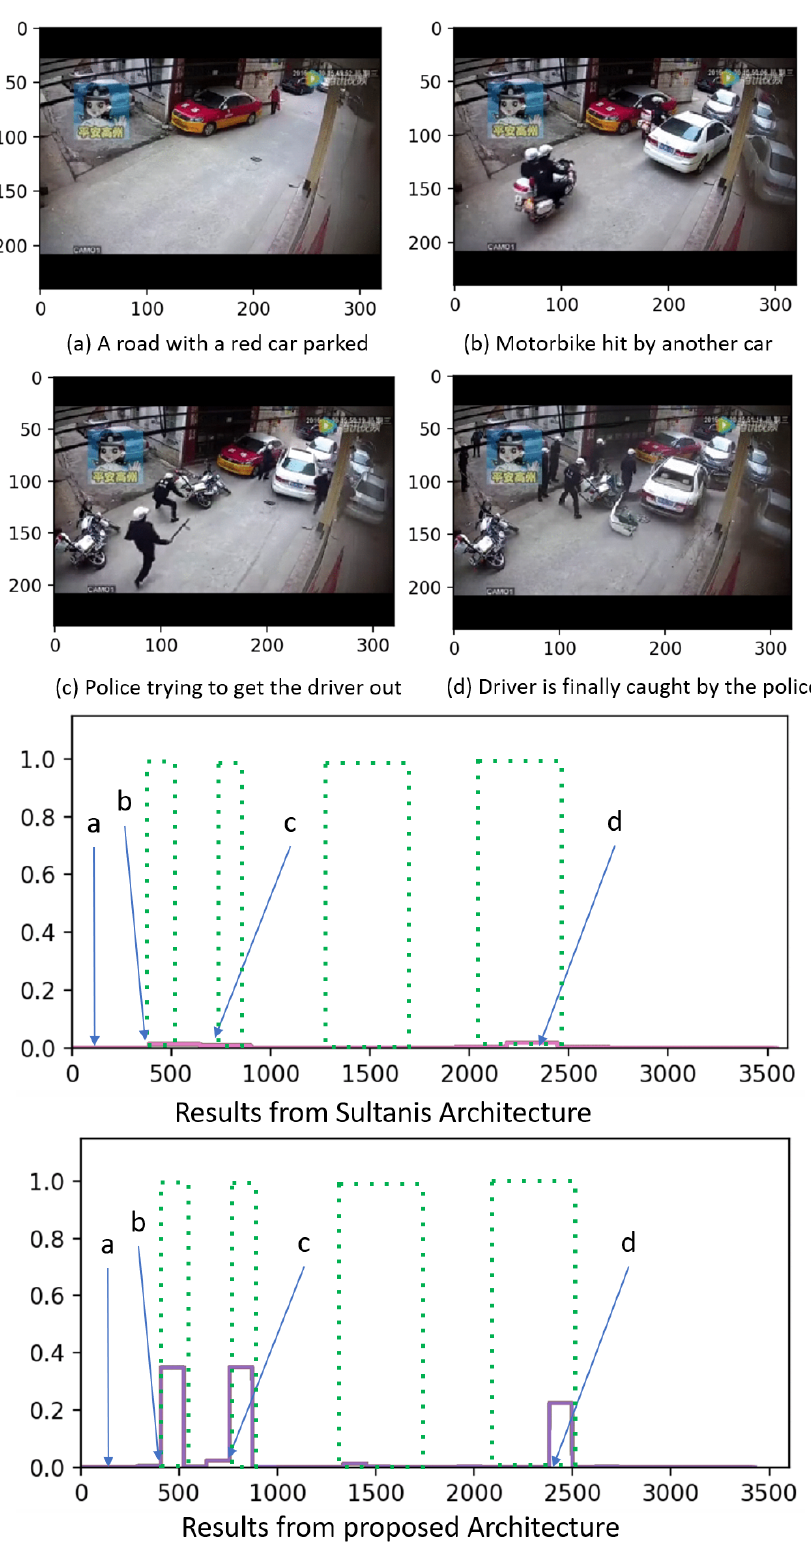
Figure 6. Qualitative visual results and comparison in scenes from